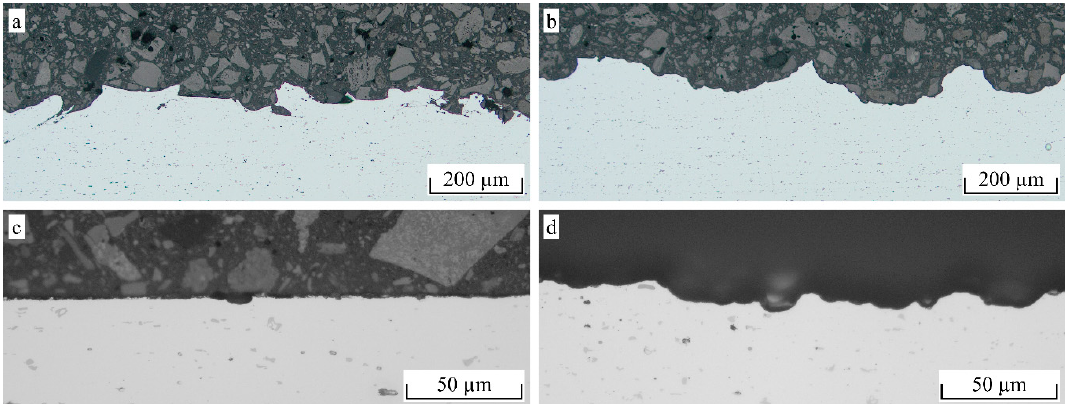
Figure 8. Cross-sections for ( a ) blasting (F16, 3 bar) ( b ) combined blasting (F16, 3 bar) and etching (5 min NaOH) ( c ) acidic etching (20 min HNO 3 ) and ( d ) alkaline etching (20 min, NaOH) treatment applied to EN AW-6082 sheets.